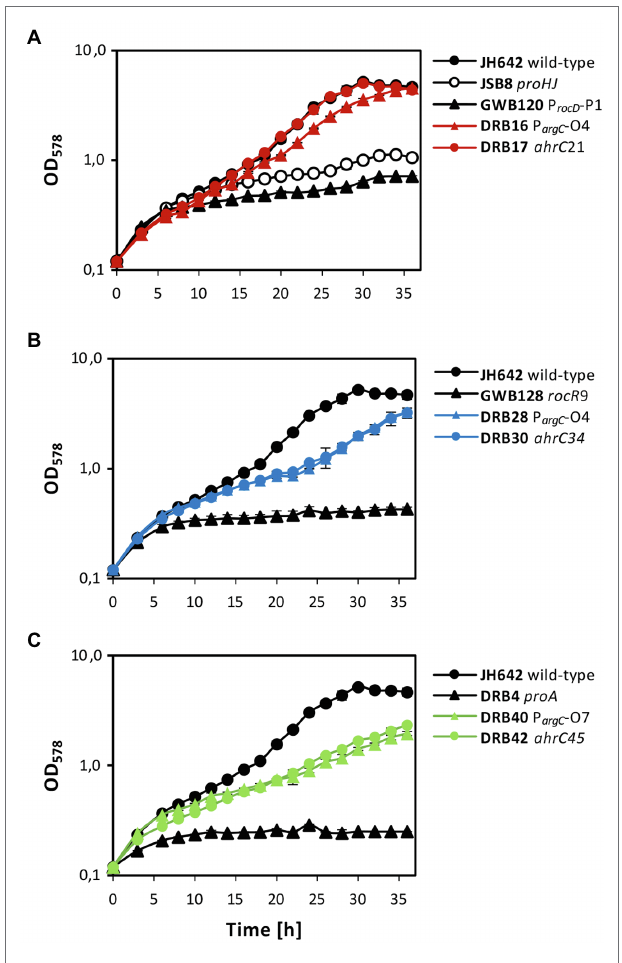
FIGURE 7 | Osmostress-resistant growth phenotype of various proA suppressor mutants. The cells were grown in shake-flasks at 37 ° C in SMM containing 1.2 M NaCl. For comparison of the various suppressor strains, the growth pattern of the B. subtilis JH642 wild-type strain and that of a strain (JSB8) defective in the osmostress-adaptive L-proline biosynthetic route ( Δ proHJ ; Brill et al., 2011a) is shown. To aid clarity of the presentation, the same growth data documented for the wild-type strain JH642 in (A) , were re-used in panels (B,C) . In each of the panels, growth of the starting strains used for the suppressor selection (GBW120, GWB128, DRB4) and two of their suppressor derivatives is shown. The shown growth curves reflect a representative growth experiment performed with two biological replicates. These experiments were repeated in an independently conducted experiment, which yielded the same